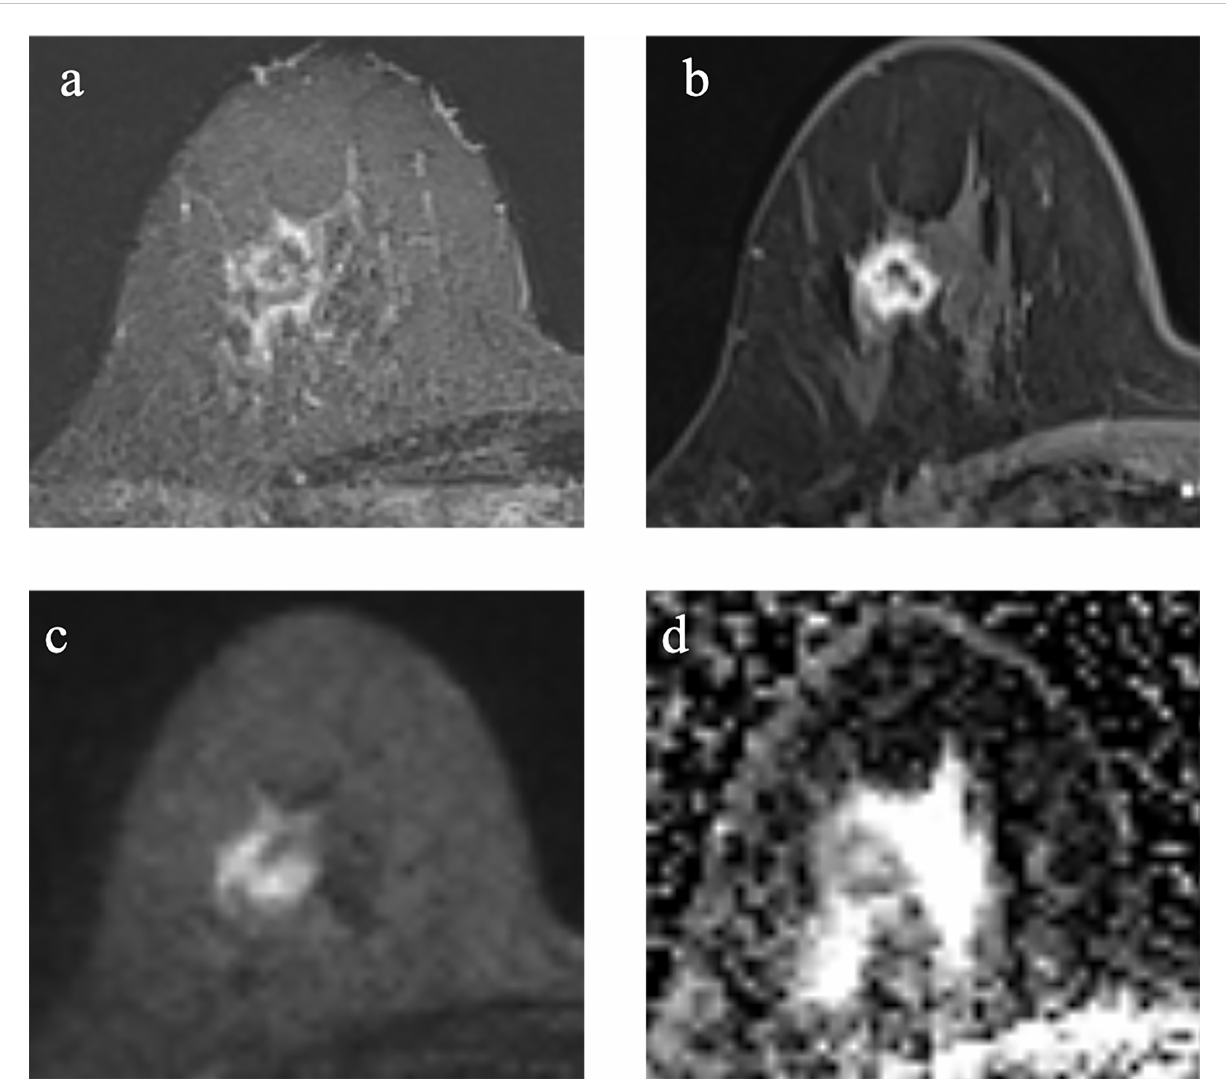
FIGURE 3 Example images of a 70-year-old woman with TNBC without TP53 mutation in the right breast. (A-D) . (A) : T2-weighted-image. (B) : the fi rst phase of T1WI after contrast enhancement. (C) : diffusion-weighted image of b 1000 . (D) : apparent diffusion coef fi cient (ADC) map.